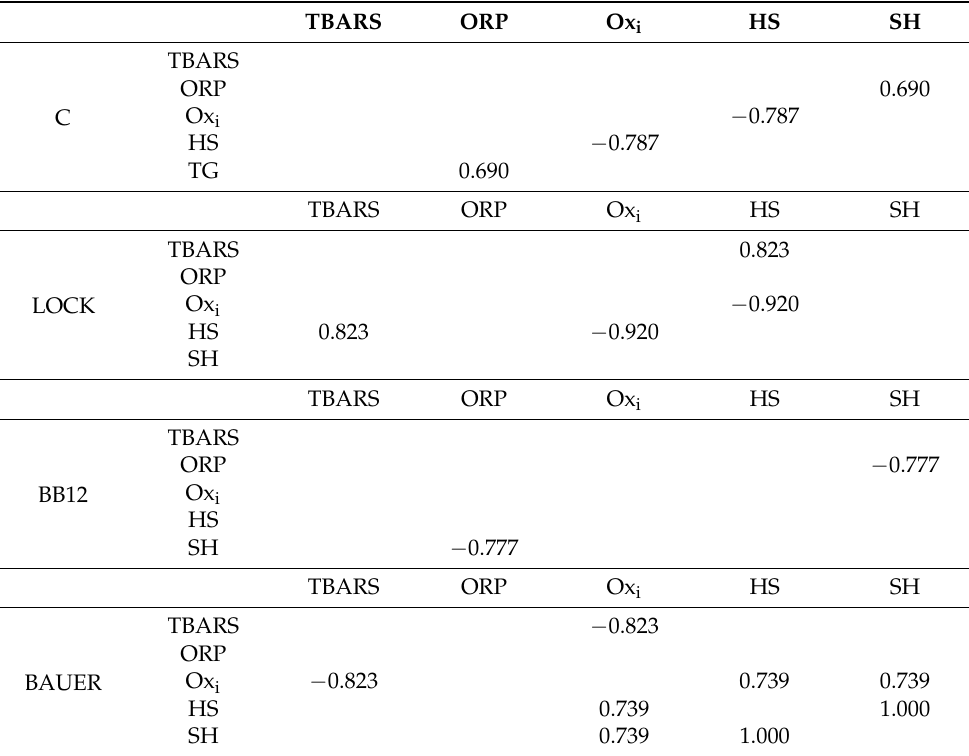
Table 4. Linear correlation coefficient for oxidation parameters (only statistically significant correla- tion ( p < 0.05) is